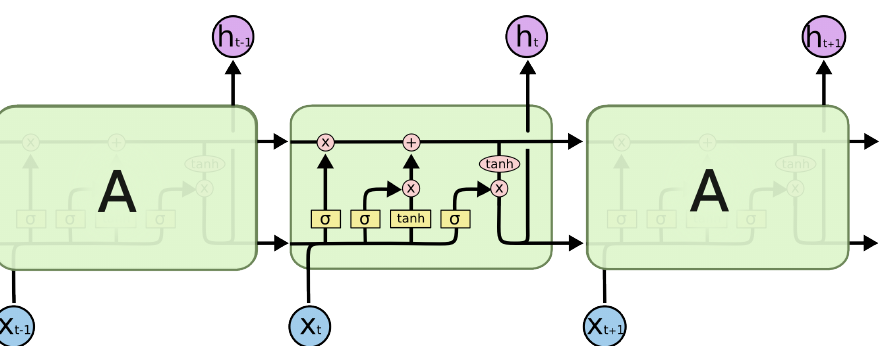
Figure 3. Every LSTM node consists of a set of cells responsible for storing passed data streams. The upper line in each cell links the models as a transport line, handing over data from the past to the present ones, and the independence of cells helps the model to filter aggregate values from one cell to another [27].